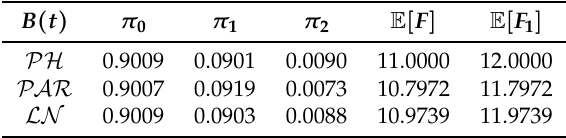
Table 2. π i , i = 0,1,2, E [ F ] and E [ F 1 ] , A ∼ E ( α ) versus B ( t ) .